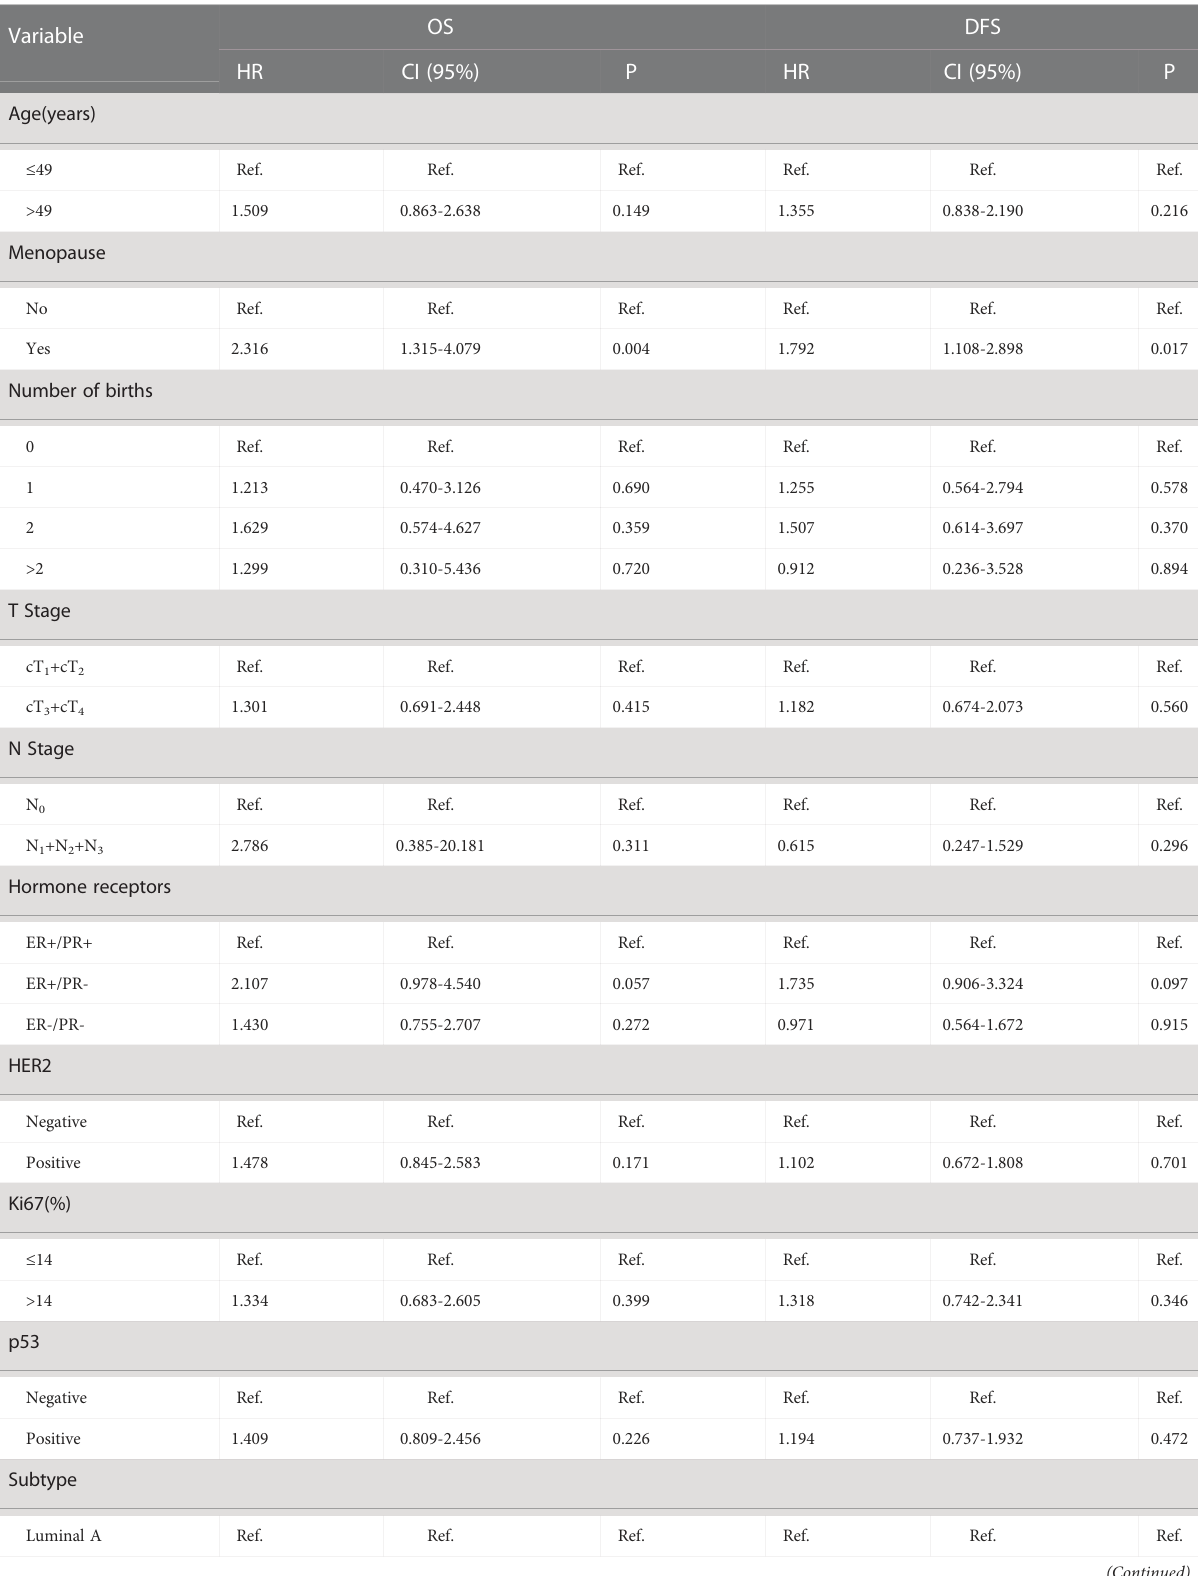
TABLE 5 Univariate analysis of hazards ratios for OS and DFS by clinical characteristics and MetS